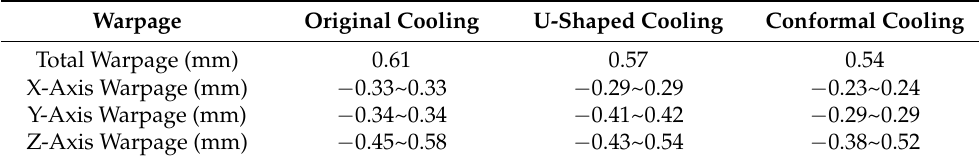
Figure 11. Comparison of Temperature Distribution Intervals. Table 18. C omparison of Warpage Deformation of Different Cooling Water Systems.